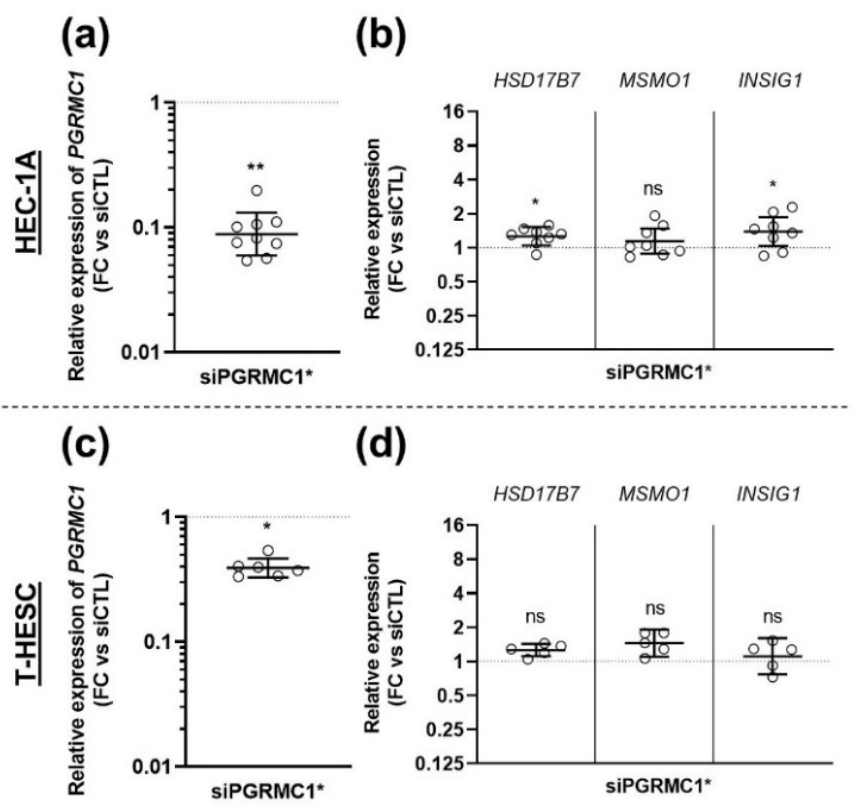
Figure 5. Down-regulation of PGRMC1 expression by another siRNA does not mimic the effect of AG-205 on target genes. HEC-1A ( a , b ) and T-HESC ( c , d ) cells were incubated with 10 nM siRNA- PGRMC1 18248 (siPGRMC1*) or control siRNA-CTL (siCTL) during 72 h. Relative expression of PGRMC1 ( a , c ), HSD17B7, MSMO1 and INSIG1 ( b , d ) was measured by RT-qPCR, normalized, compared to siCTL values and is presented as individual fold changes (FC) in log or log2 scale and as geometric means with geometric SD ( n = 5–8). Statistical test: Wilcoxon paired test, not significant (ns), * p < 0.05, ** p < 0.01.